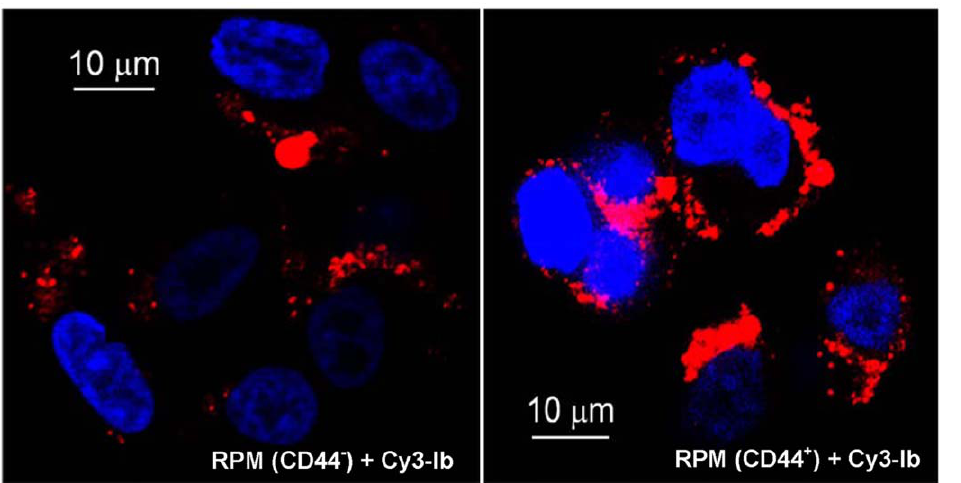
Figure 3. Comparative binding of Ib to CD44 + , versus CD44 2 , cells. Confocal microscopy was done with RPM (CD44 2 and CD44 + ) cells incubated with Cy3-labeled Ib (10 2 7 M in DMEM + 0.1% BSA) for 3 min at 37 u C, washed with PBS, and mounted in mowiol. Blue represents Dapi- stained nuclei and red indicates cell-bound Ib. A representative field of cells is shown.